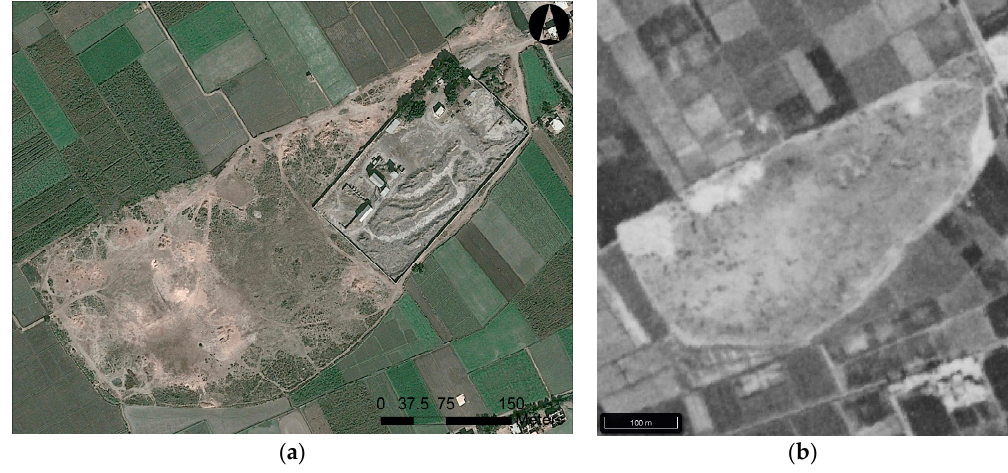
Figure 12. ( a ) The site of Kom ed Dahaba. Image courtesy Google Earth; ( b ) 1968 CORONA image. Image courtesy of the Center for Advanced Spatial Technologies, University of Arkansas/U.S. Geological Survey.